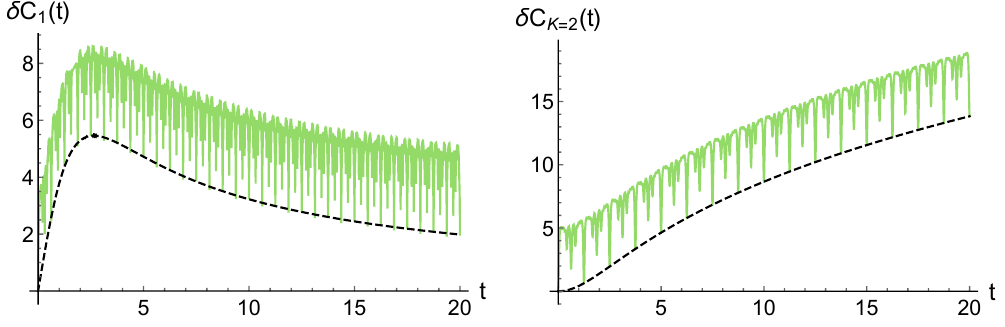
Figure 24 . δ C ( t ) for the same variables as in the central panels of figure 23 except a for lower value of the potential Ω = 0 . 2 . This reflects in a shorter periodicity and lower